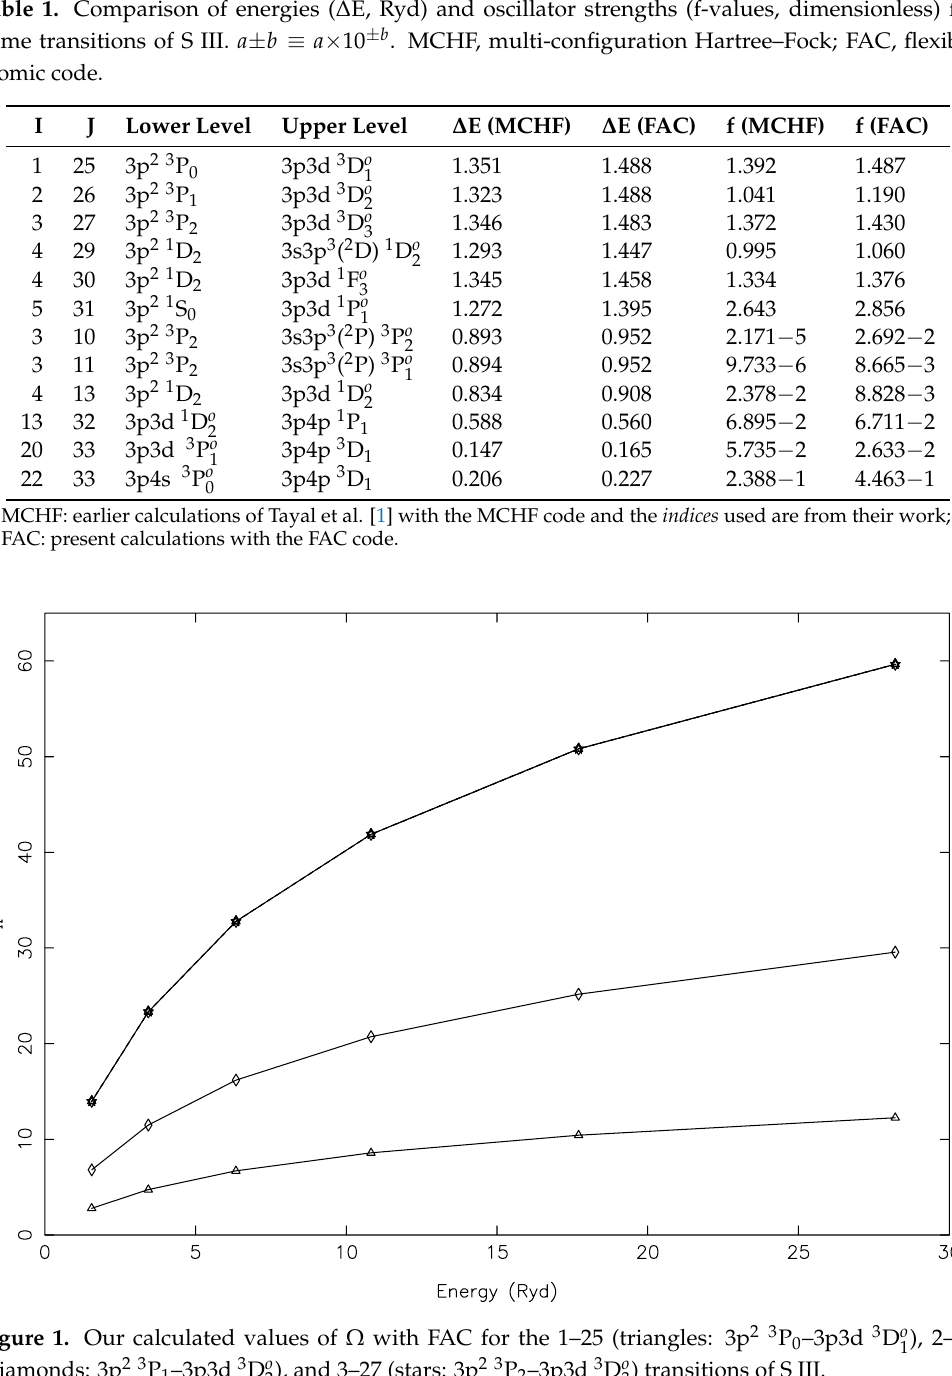
), and 3–27 (stars: 3p 2 3 P 2 –3p3d 3 D o 2